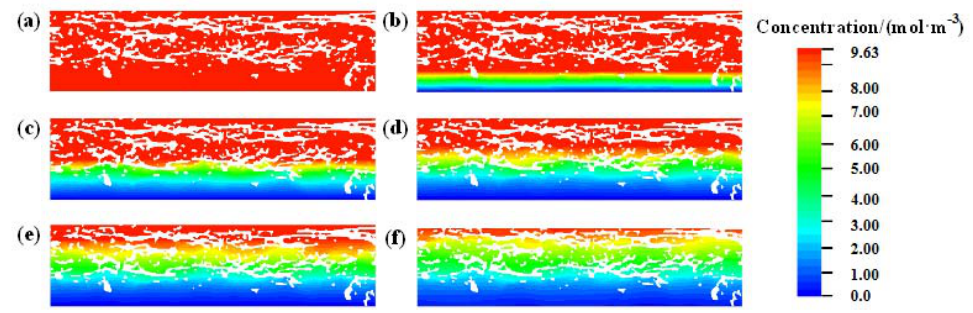
Figure 7. Oxygen concentration distribution: ( a ) 0% filling degree; ( b ) 20% filling degree; ( c ) 40%